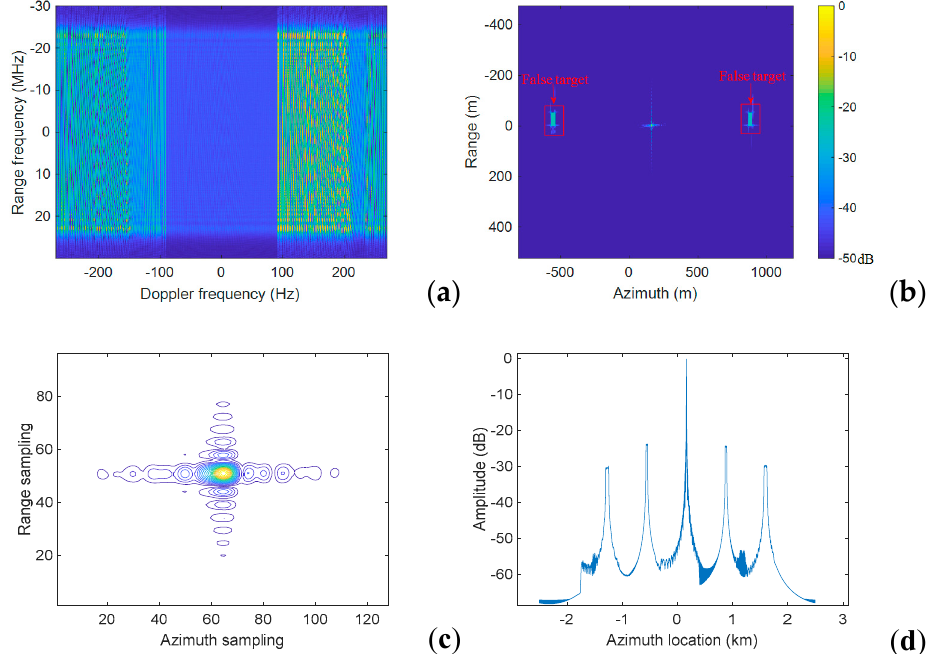
Figure 7. Simulation results of the moving target with the slant velocity of 10 m/s. ( a ) Reconstructed two-dimension spectrum. ( b ) The focused point target. ( c ) Contour plots of the point target. ( d ) The maximum azimuth projection profile.